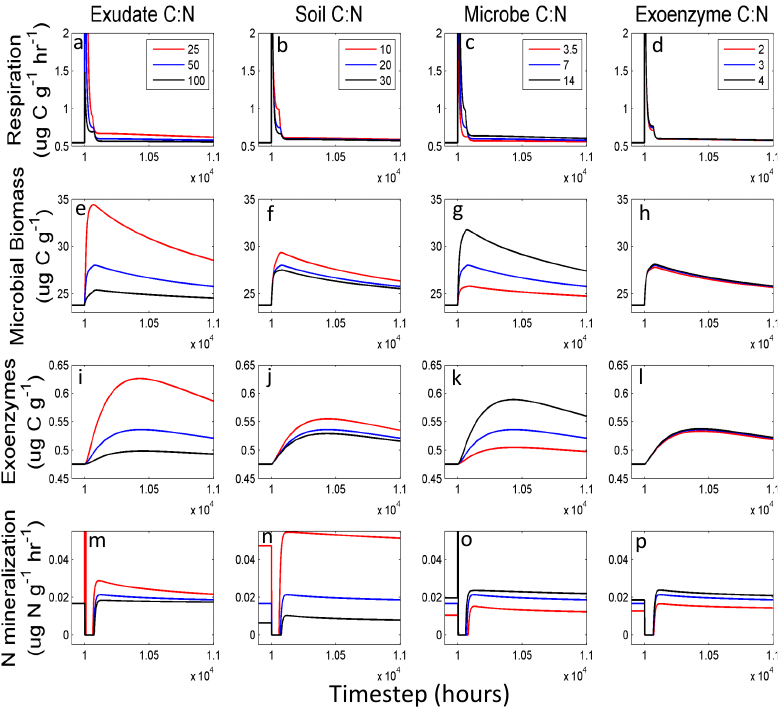
Figure 2. Model responses of respiration, microbial biomass, soil enzymes, and N mineralization to an exudate pulse depend on stoichiometry. The model was “spun-up” for 1x10 4 timesteps to reach steady state and a pulse of DOC and DON was added. The model was run at the moderate value for each parameter (Table 1) except the parameter that was varied. In general, the response to an exudate pulse was greatest when N availability was high (low exudate C:N and low soil C:N) and microbial N demand was low (high microbial C:N and high enzyme C:N).